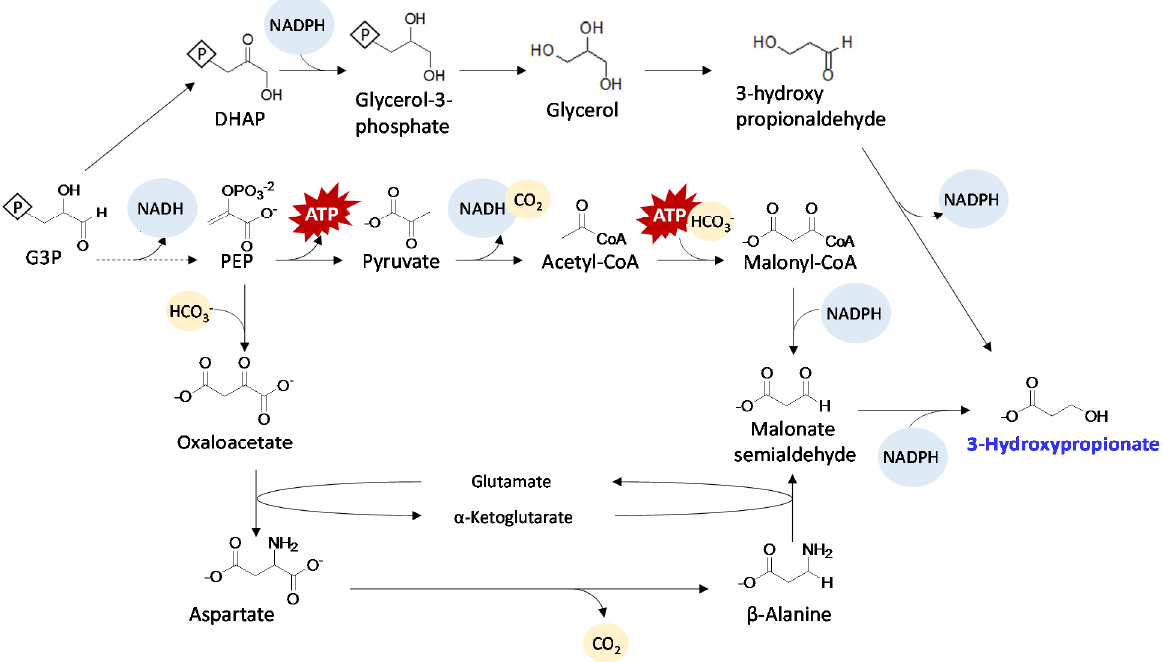
Figure 5. Schematics of 3HP production